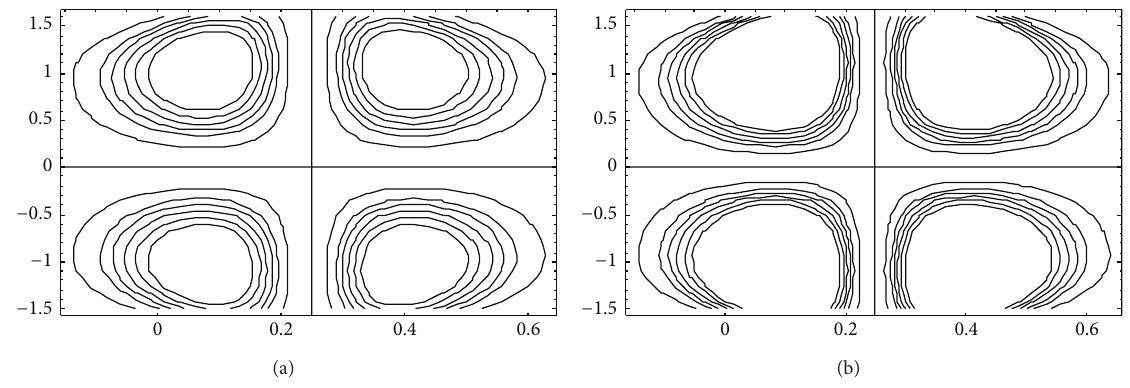
Figure 8: Streamlines when 𝛽 = 0.05 , 𝐸 1 = 0.1 , 𝐸 2 = 0.1 , 𝜀 = 0.1 , 𝛿 = 0.01 , 𝑡 = 0.0 , 𝑅 = 0.01 , 𝑀 = 1 , 𝜆 1 = 0.1 , and 𝜆 2 = 0.05 . (a) 𝐸 3 = 0.1 and (b) 𝐸 3 = 0.5